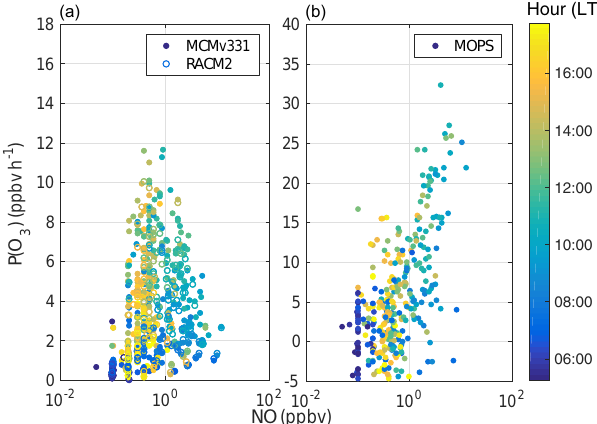
Figure 2. Full-campaign median hourly P(O 3 ) measured by the MOPS and modeled by RACM2 and MCMv331 for MOPS mea- surement days. Shaded areas represent the variance in MOPS P(O 3 ) due to the variation in the zero correction. The RACM2 and MCMv331 relative error bars are shown at the 1 σ confidence level.